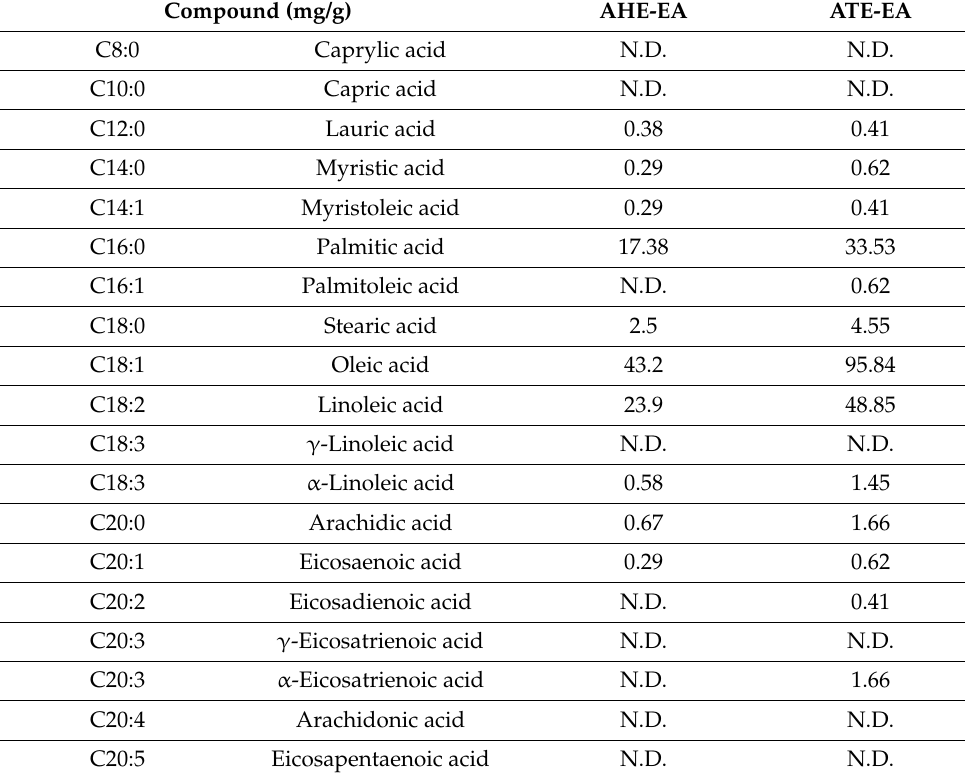
Compound (mg/g) AHE-EA